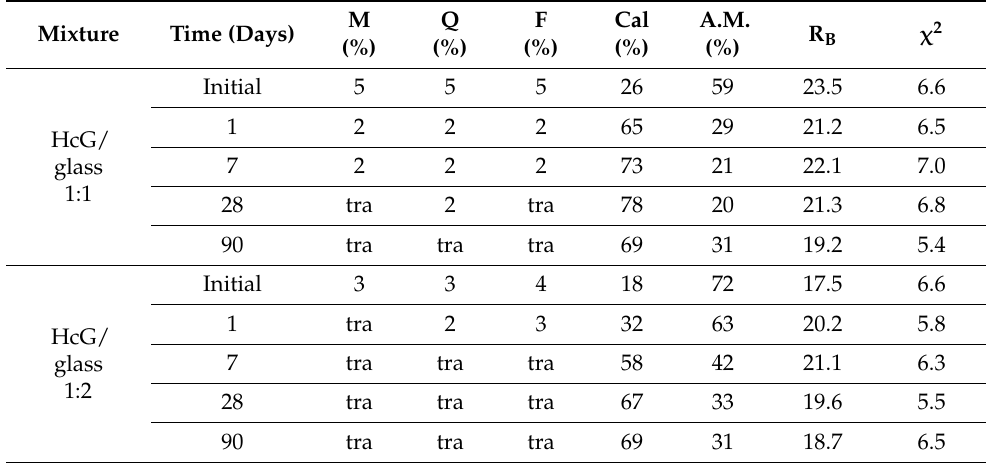
Table 4. Variation of mineralogical composition by XRD in the different binary mixtures in the studied times (M = Mica; Q = Quartz; F = Feldspars; Cal = Calcite; A. M. = Amorphous Materials; tra = traces; R B and χ 2 , adjustment